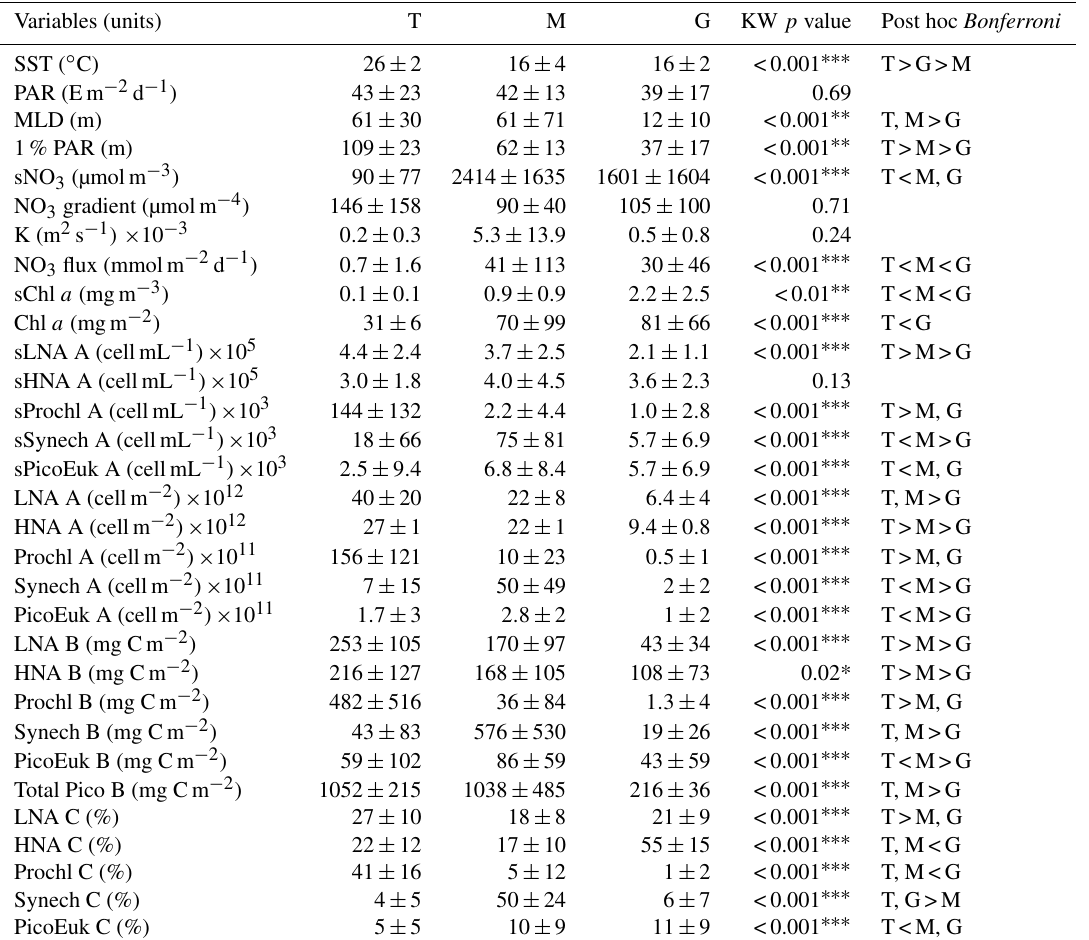
Table 2. Mean ± standard deviation of sea surface temperature (SST), surface photosynthetic active radiation (PAR), mixed-layer depth (MLD), photic layer depth (1% PAR), surface nitrate concentration (sNO 3 ), nitrate gradient, vertical diffusivity (K), nitrate supply (NO 3 flux), surface chlorophyll (sChl a ), photic layer depth-integrated chlorophyll a (Chl a ); biomass (B), abundance (A), and contribution (C) to total picoplankton biomass (Total Pico B); and surface abundance (s) of LNA and HNA bacteria, Prochlorococcus , Synechococcus and picoeukaryotes computed for the tropical and subtropical Atlantic Ocean (T), the Mediterranean (M), and the Galician coastal upwelling (G). MLD was estimated from an increase in water column density of 0.125Kgm − 3 relative to surface values. A nonparametric one-way ANOVA (Kruskal–Wallis) was performed to test the null hypothesis that independent groups come from the same distribution. The Bonferroni multiple comparison test was applied a posteriori to analyze the differences between every pair of groups ( ∗ p < 0 . 05; ∗∗ p < 0 . 01; ∗∗∗ p < 0 .